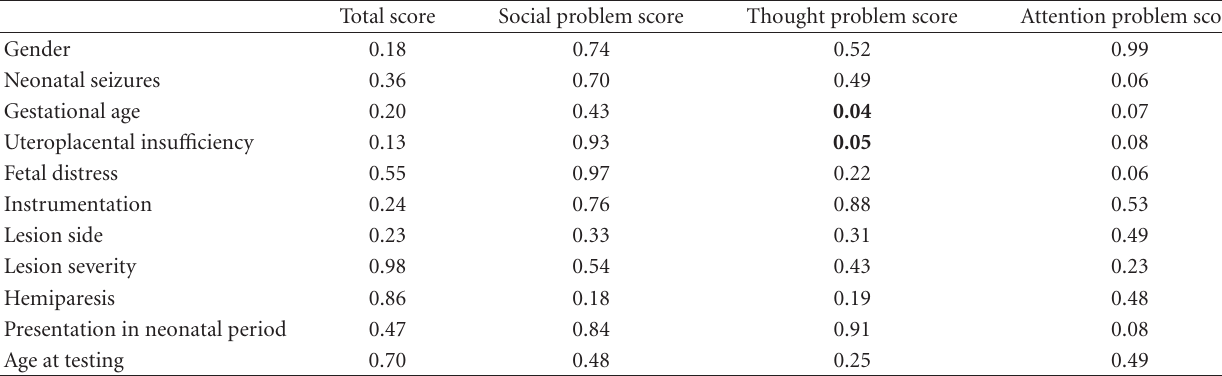
Table 1: P values reflecting perinatal risk factors and elevated CBCL scores. ∗